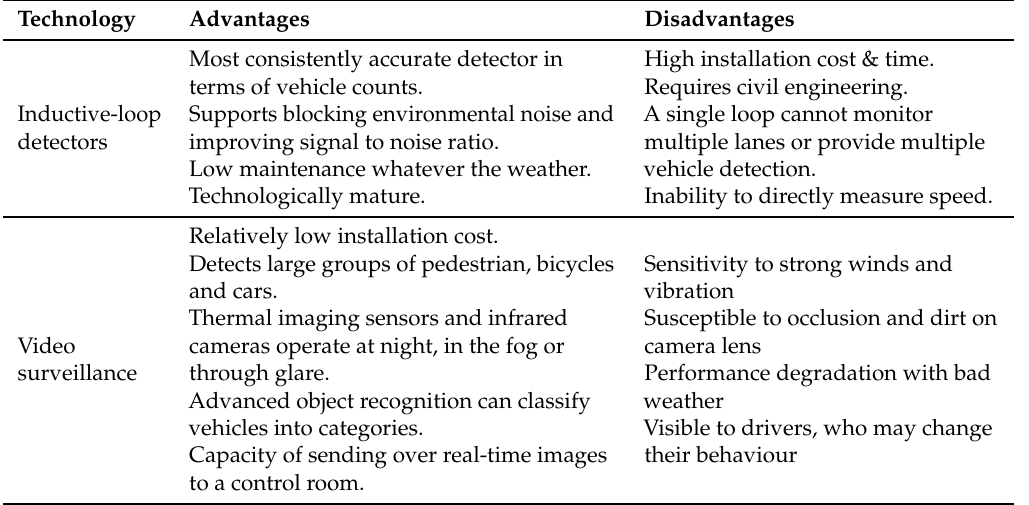
Table 3. Comparison between video-based detection and inductive-loop based direct